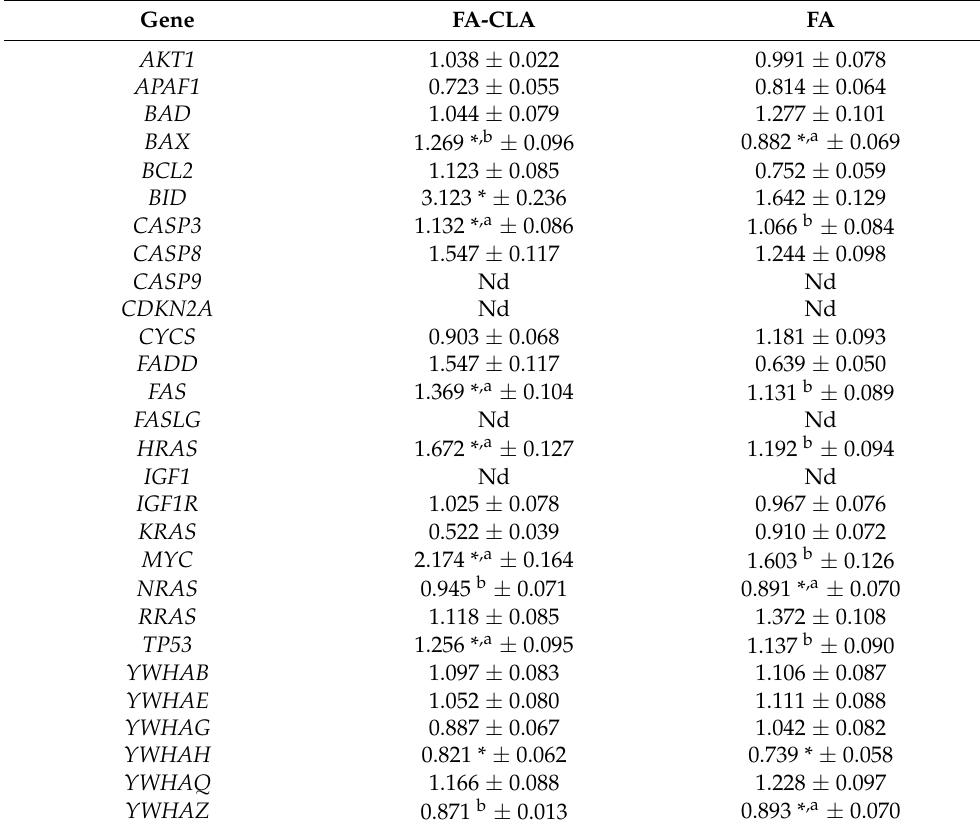
Table 2. Expression of genes related to apoptosis and cell cycle in cancer cells of WM793 line exposed to a mixture of CLA-enriched and non-enriched fatty